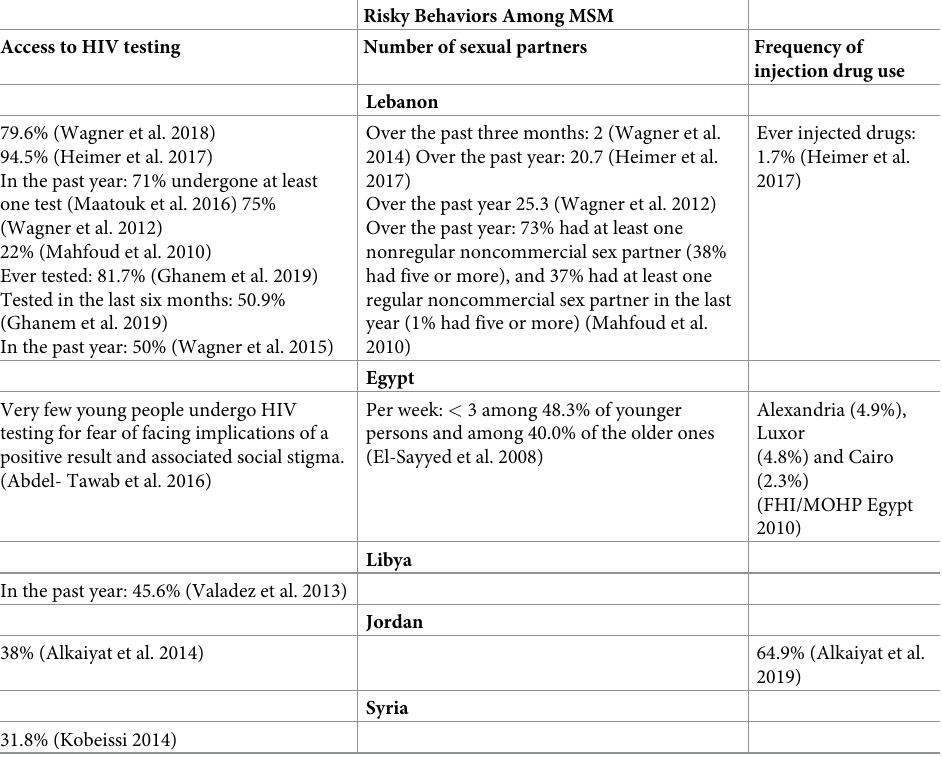
Table 2. Risky behaviors among men who have sex with men (MSM) in the MENA